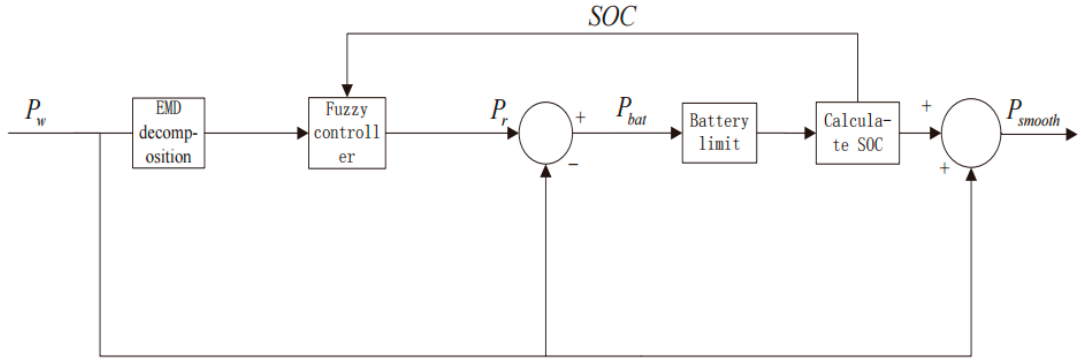
Figure 12. Empirical mode decomposition (EMD) based Control method with BESS.